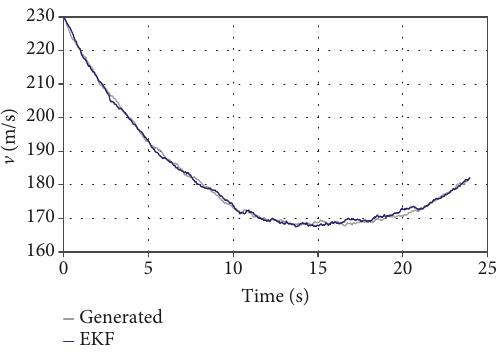
Figure 5: Simulated and estimated trajectories of ICP-89 aerial target imitator.